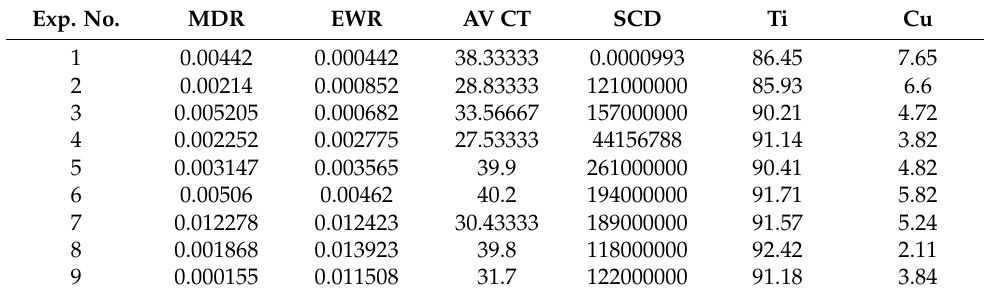
Table 7. Decision matrix.